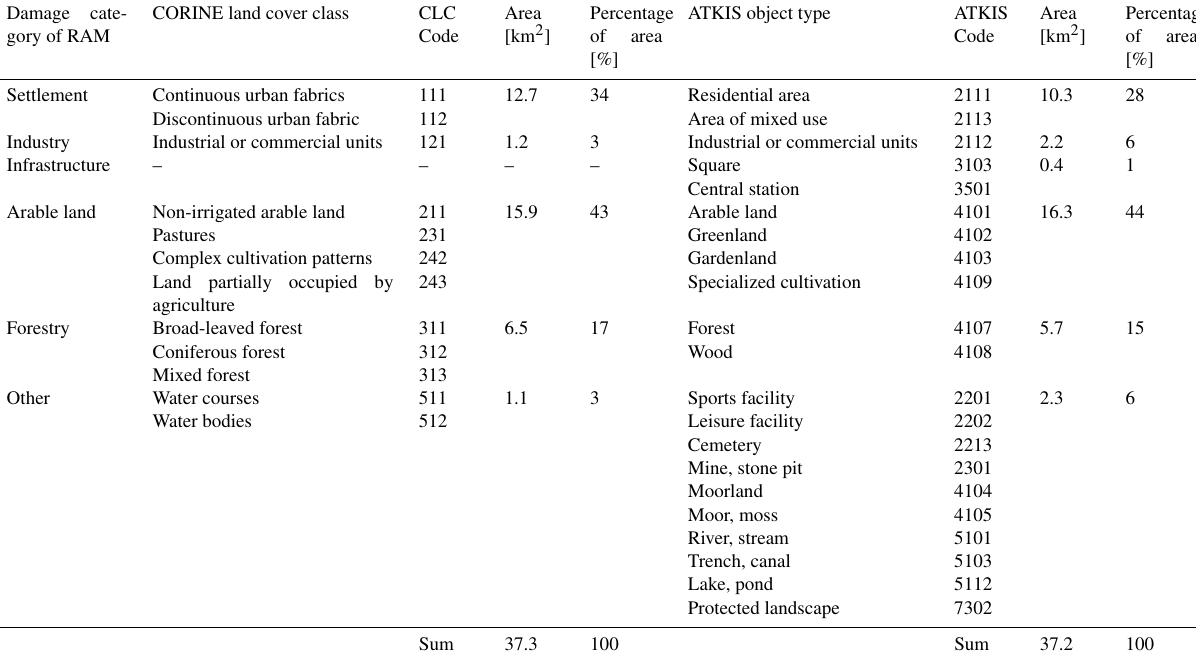
Table 3. Assignment of the CORINE and ATKIS land cover classes of Rosenheim to the damage categories of the Rhine Atlas model (RAM) (CLC 2006, ATKIS ® -Basis-DLM